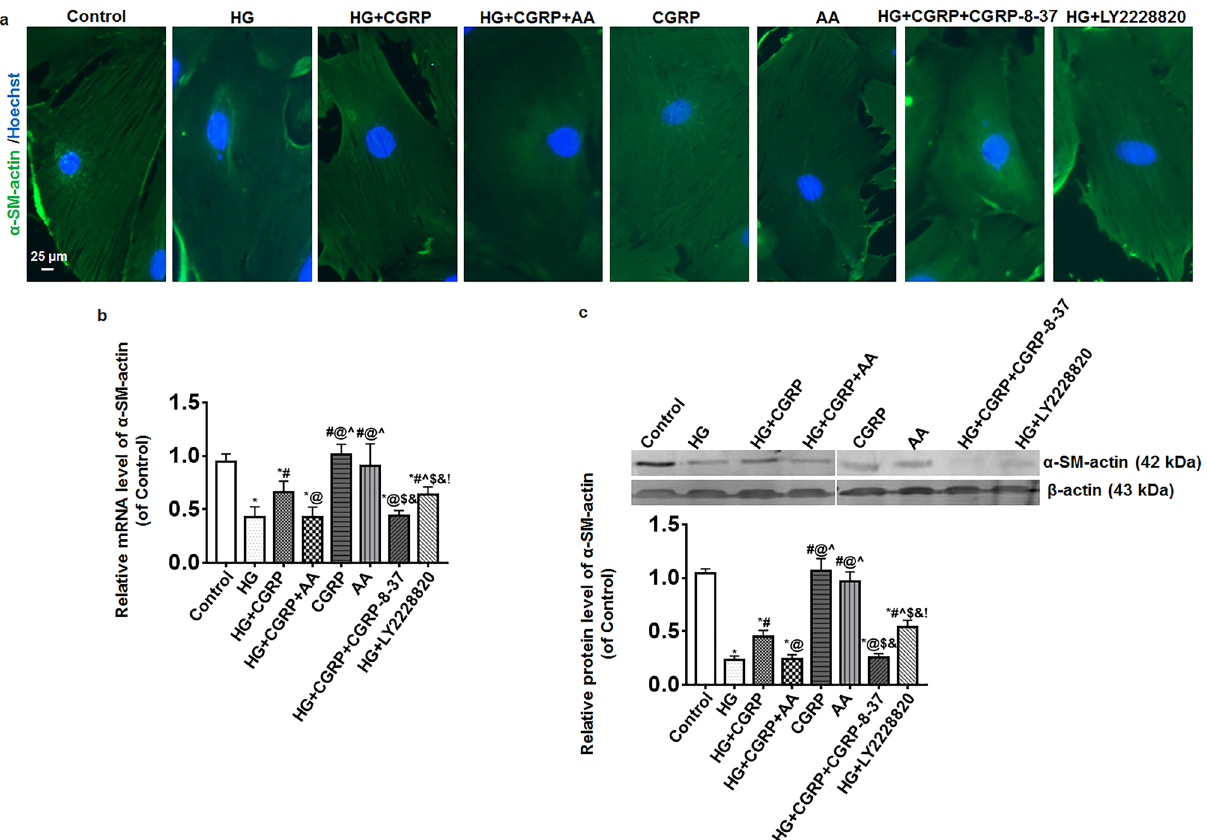
Figure 3. The expression of α-SM-actin in BSMCs was measured by immunofluorescence, qRT-PCR and Western blot. ( a ) The result of immunofluorescence showed the visible α-SM-actin fibers in BSMCs were found in the control, CGRP, AA, HG + CGRP and HG + LY2228820 groups while they were unclear in the HG, HG + CGRP + AA and HG + CGRP + CGRP-8-37 groups. ( b , c ) Compared with the control, CGRP and AA groups, the mRNA and protein expressions of α-SM-actin in the HG group, the HG + CGRP + AA and HG + CGRP + CGRP-8-37 groups were significantly decreased. Though the expression of α-SM-actin mRNA and protein in the HG + CGRP and HG + LY2228820 groups also deceased, it was higher than that in the HG, HG + CGRP + AA and HG + CGRP + CGRP-8-37 groups. * VS. control group, p < 0.05; # VS. HG group, p < 0.05; @ VS. HG + CGRP group, p < 0.05; ^ VS. HG + CGRP + AA group, p < 0.05; $ VS. CGRP group, p < 0.05; & VS. AA group, p < 0.05; ! VS. HG + CGRP + CGRP-8-37 group, p < 0.05. Bar = 25 μm. n = 6. The bar charts were created by GraghPad Prism 7.0 software (Version 7.00, URL: www. graph pad. com). The Western blot bands were created